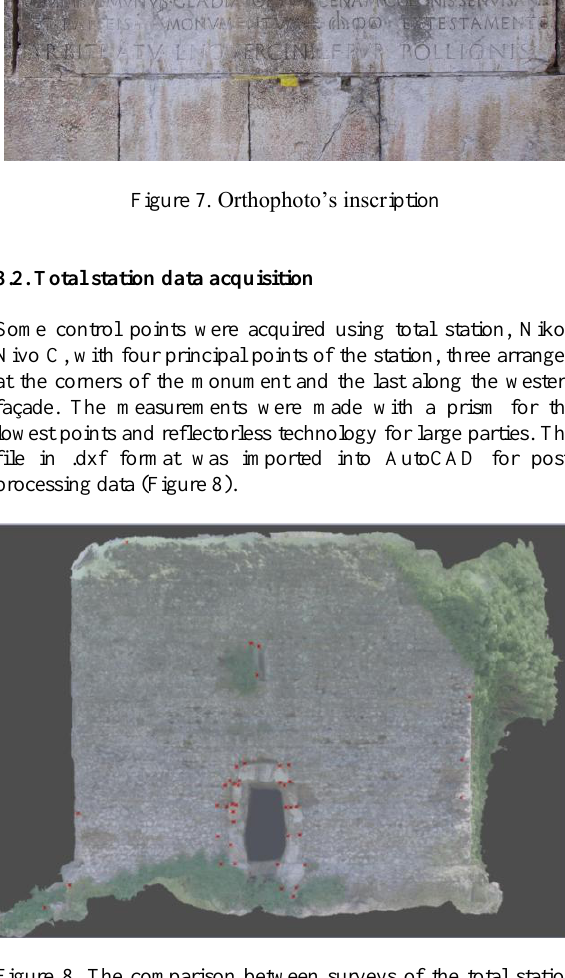
Figure 8. The comparison between surveys of the total station and the IBM method.